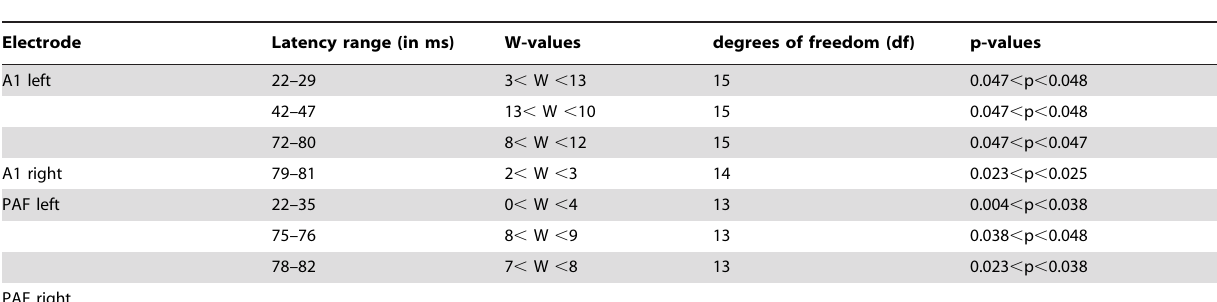
Table 3. Significant differences between MMN amplitudes of different deviant probabilities (always MMN 0.1 . MMN 0.2 ).